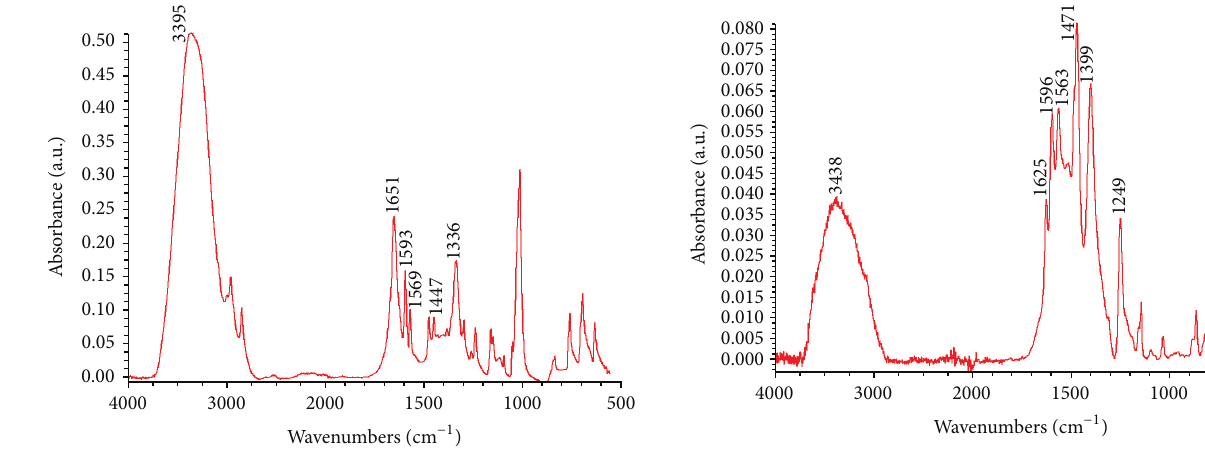
Figure 4: Infrared spectrum (4000–500 cm −1 ) of PA:NC via syn- thetic Route 2 (methanol synthesis).